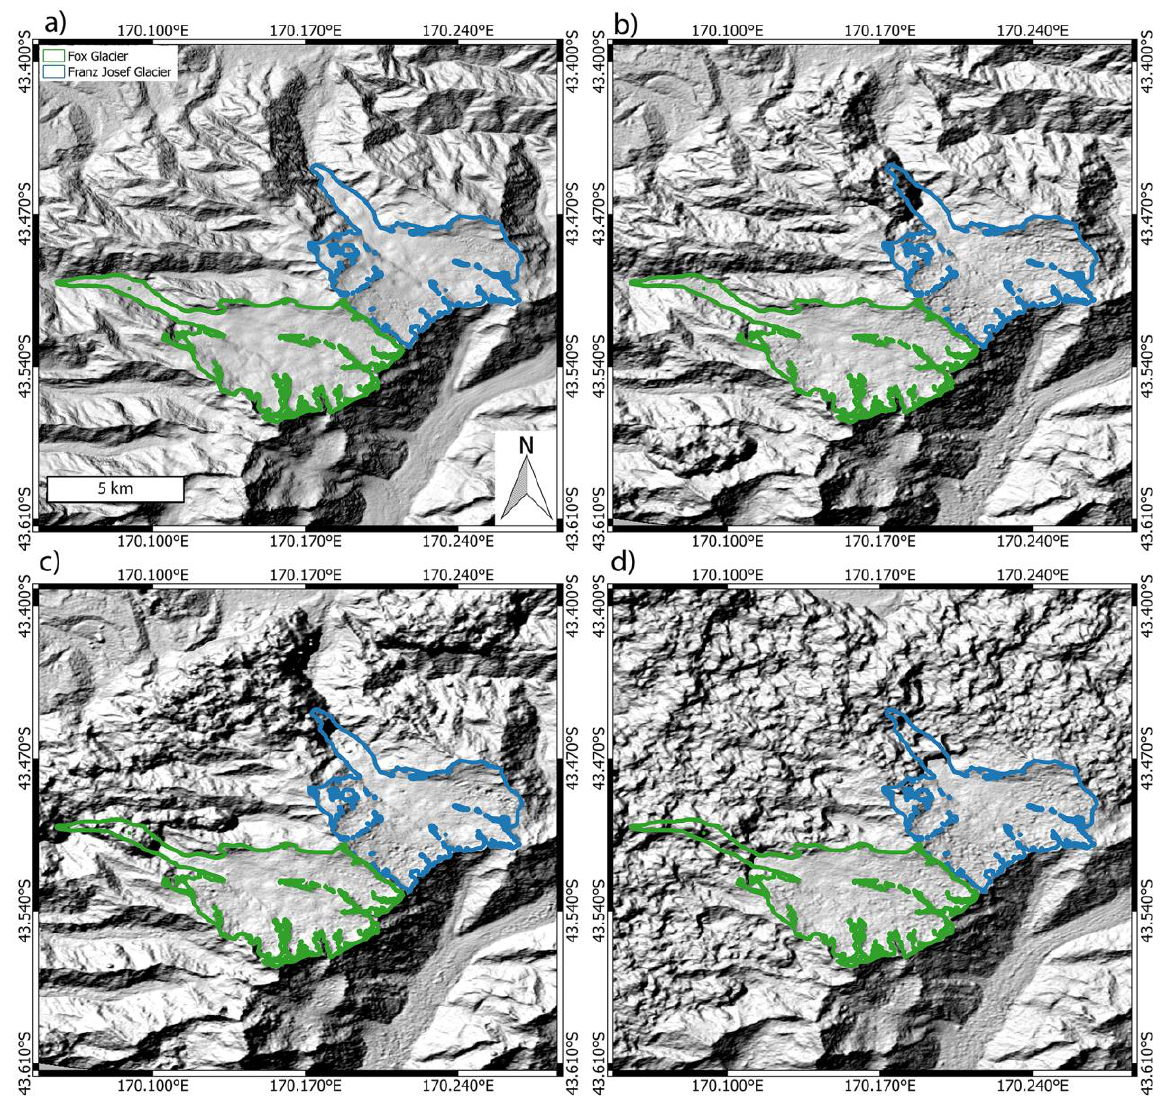
Figure 2. Different typical example ASTER DEMs over the study area. ( a ) ASTER GDEM2 features smooth terrain without outliers ( b ) ASTER DEM 2001/04/07 contains noticeable outliers over the glacier tongues, as do ( c ) ASTER DEM 2001/08/09 and ( d ) ASTER DEM 2014/02/24. The examples illustrate that any time series analysis has to be particularly robust against elevation